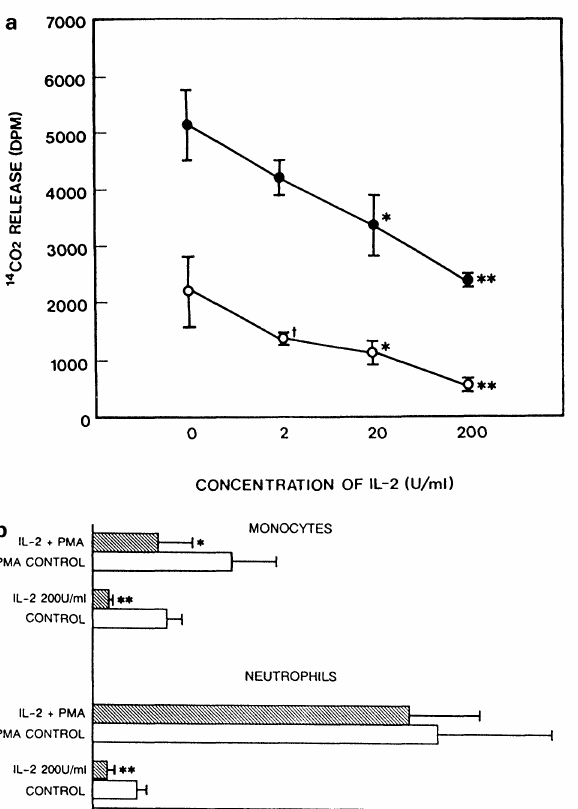
FIG. 4. (a) Effect of increasing IL-2 concentrations reduced both neutrophil (0) and monocyte (O) hexose monophosphate shunt activity. Final cell concentrations were x 106neutrophil/ml and 5 x 105monocyte/ml. **p_<0.001, *p<0.01, Tp_<0.05. (b) Mono- cytes preincubated with IL-2 at 200 U/ml for 30 min displayed reduced HMPS activity even after stimulation by PMA. Neutrophils no longer showed a significant response to IL-2 after stimulation by PMA. The control indicates the uptake of cells which did not have IL-2 added, but were otherwise treated similarly to the IL-2 test suspensions. Experimental conditions were as for (a). Statistical comparisons were made between the control/PMA control (I-]) and the respective IL-2 test (11) activity, i.e. adjacent bars. p _< 0.01, p < 0.001.